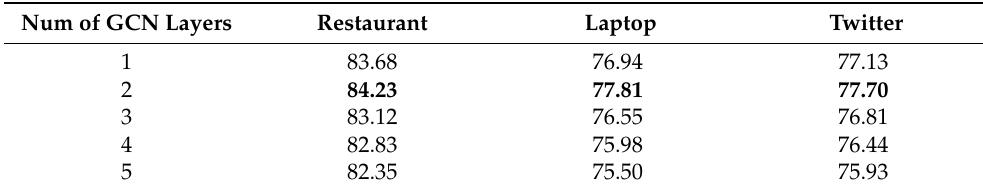
Table 3. ALSC accuracy in line with GCN layer numbers.